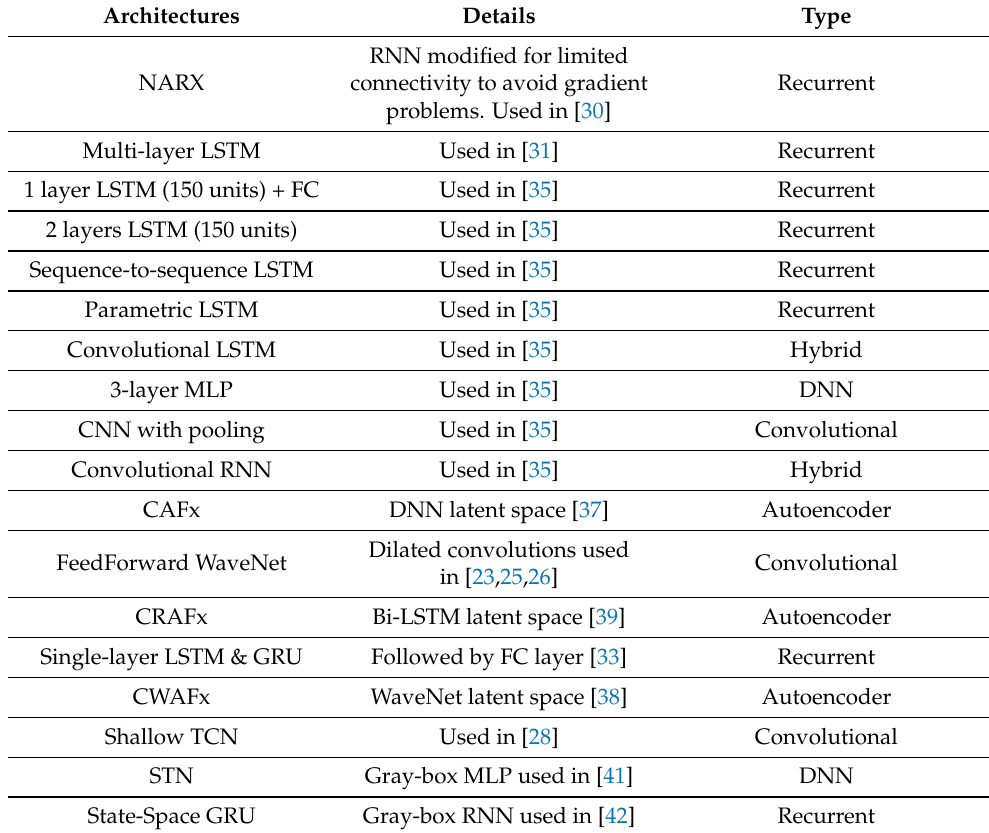
Table 2. Summary of the architectures for distortion circuit modelling comprising recurrent, convolu- tional, and hybrid